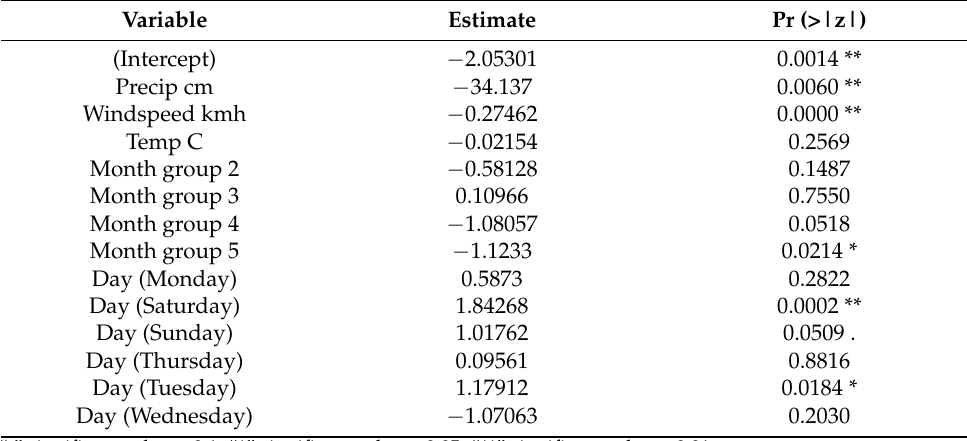
Table 4. Logistic regression output. Negative values indicate a decrease, and positive values an increase, in the number of days with PM 2.5 averages above WHO guidelines. Variable Estimate